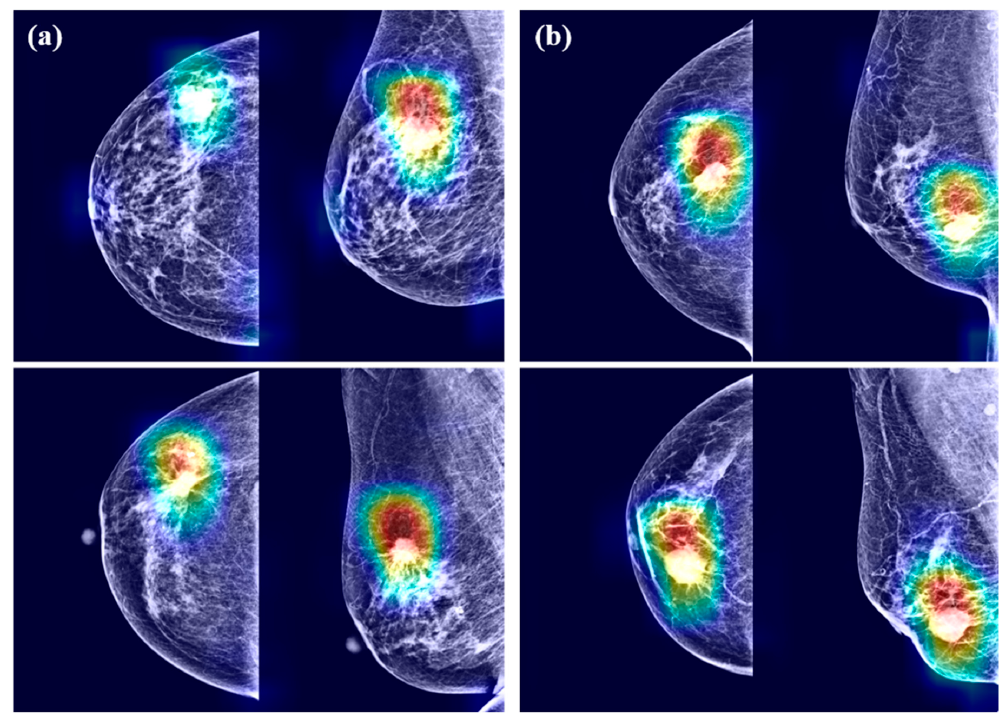
Figure 4. Gradient-weighed class activation mapping for mammograms having breast cancer by ( a ) DenseNet-169 and ( b )